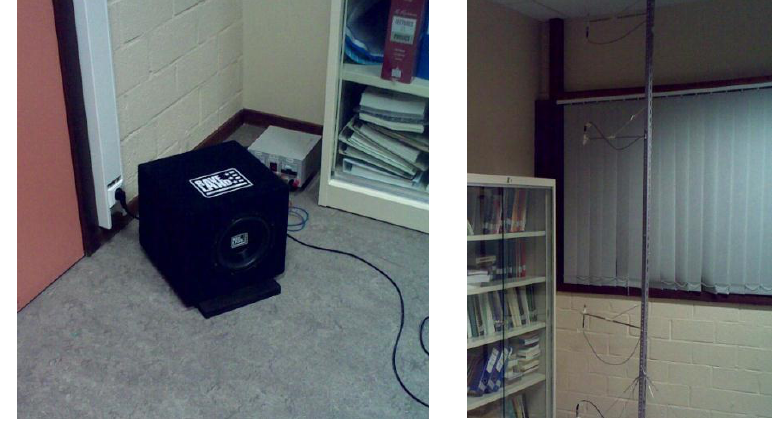
Fig. 15. Loudspeaker and